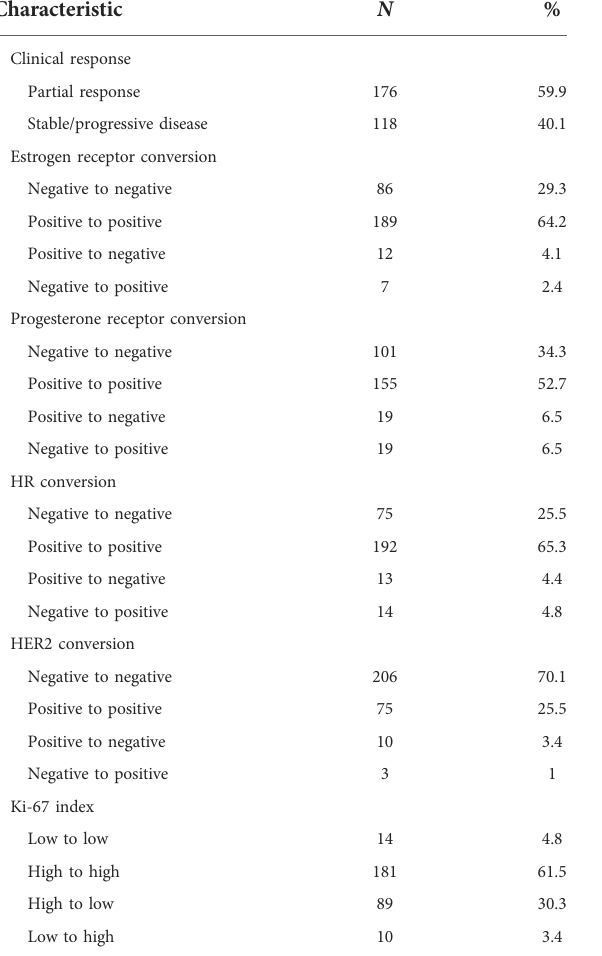
TABLE 2 Comparison of the clinicopathological characteristics between the HR concordant and disconcordant groups.